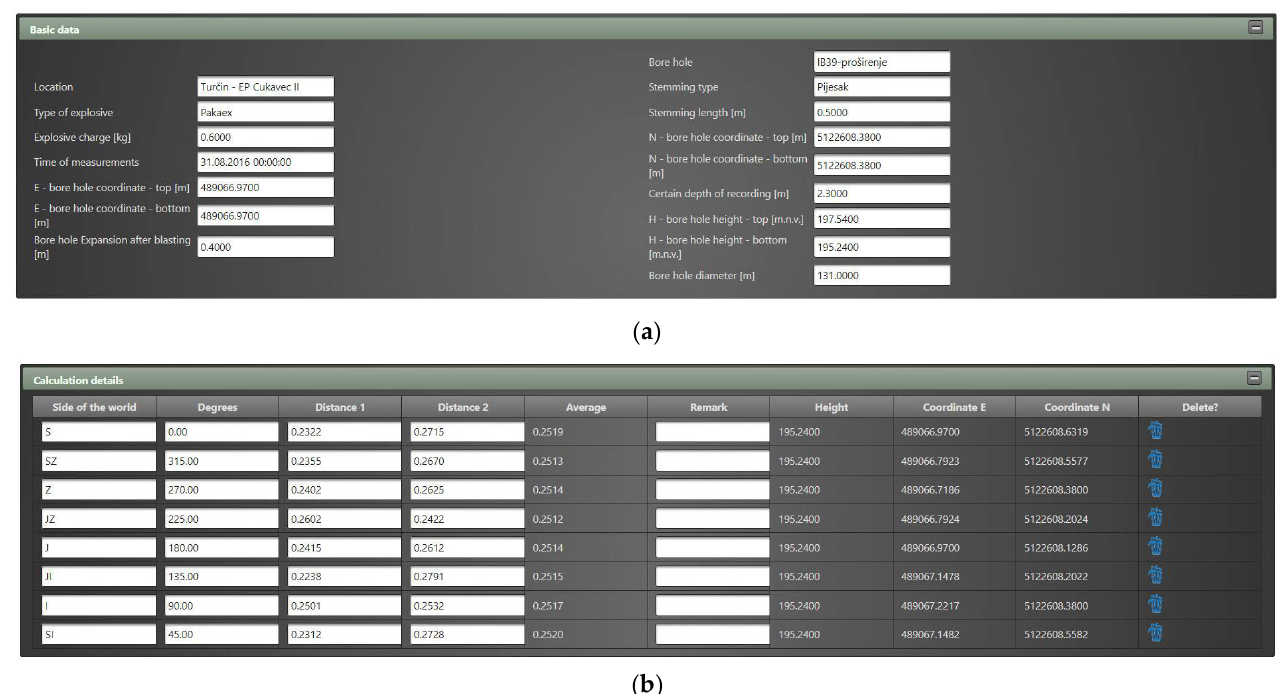
Figure 4. ( a ) Basic data about the borehole. ( b ) Input and calculation of the coordinates of individual sections of the borehole [4].